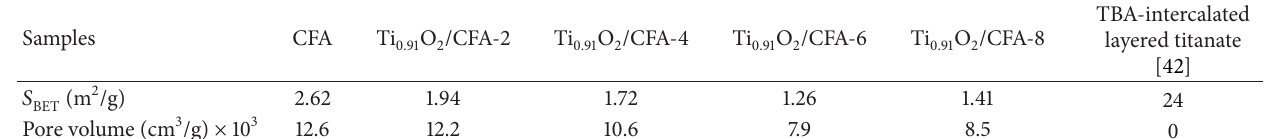
Table 2: BET surface area and pore volume of CFA and Ti